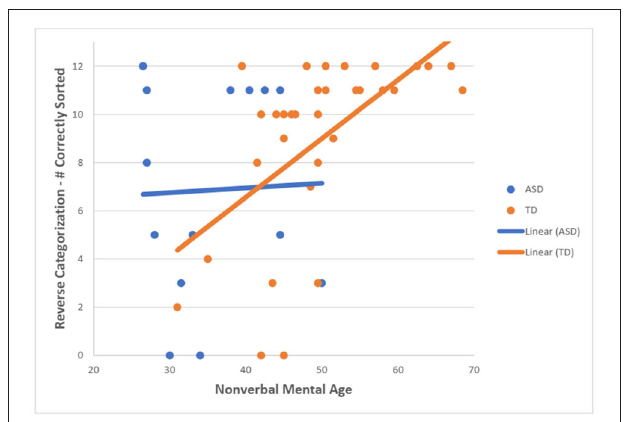
FIGURE 3 | Scotterplot showing the relationship between NVMA and a number of correctly sorted post-switch RC trials for both groups.